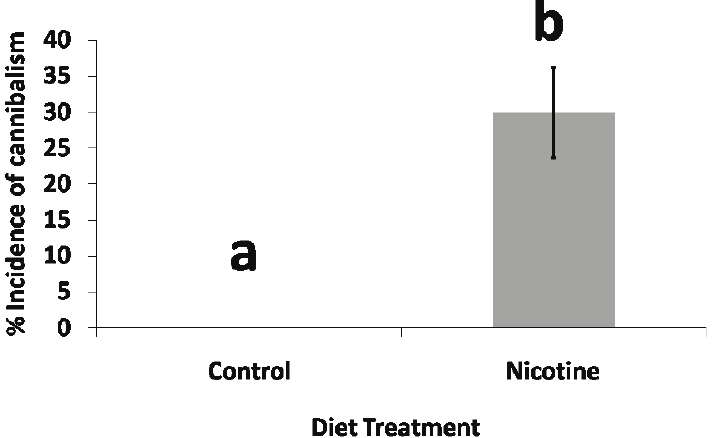
Figure 3. Cannibalism bioassay. Helicoverpa zea caterpillar pairs sharing artificial diet laced with nicotine (1.5 µg nicotine/ mg diet) encountered significantly more incidences of cannibalism than H. zea caterpillar pairs sharing artificial control diet (N = 60, Wilcoxon, p < 0.0044, df =